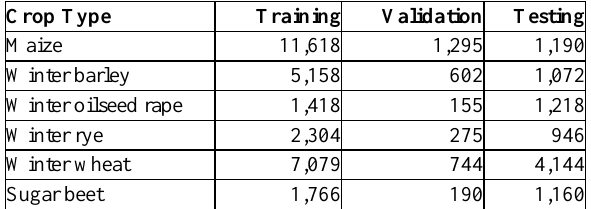
Table 1. The number of samples for each crop class.